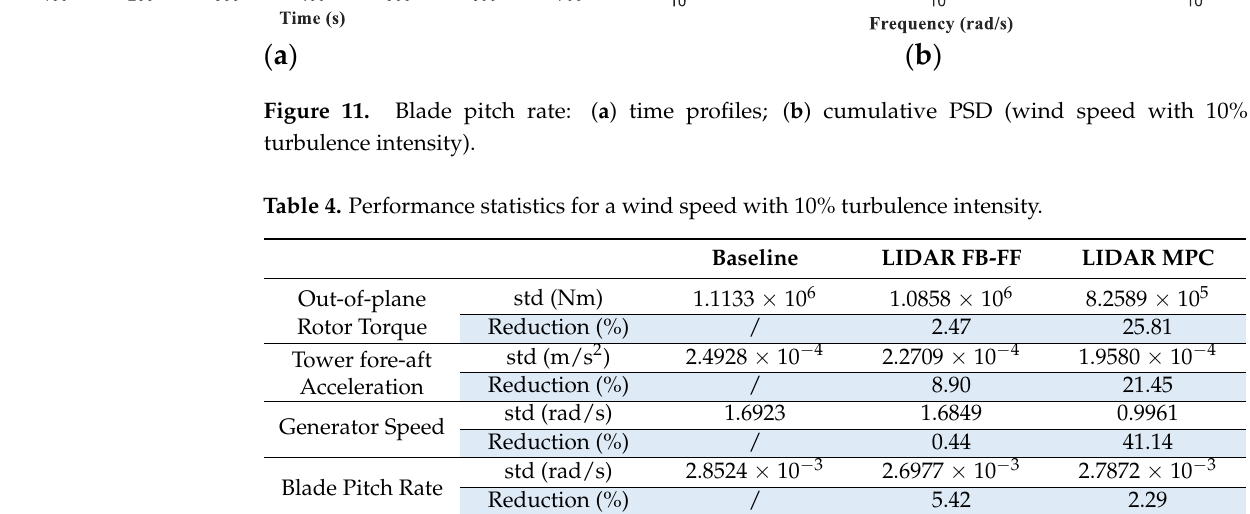
Figure 11. Blade pitch rate: ( a ) time profiles; ( b ) cumulative PSD (wind speed with 10% turbulence Figure 11.